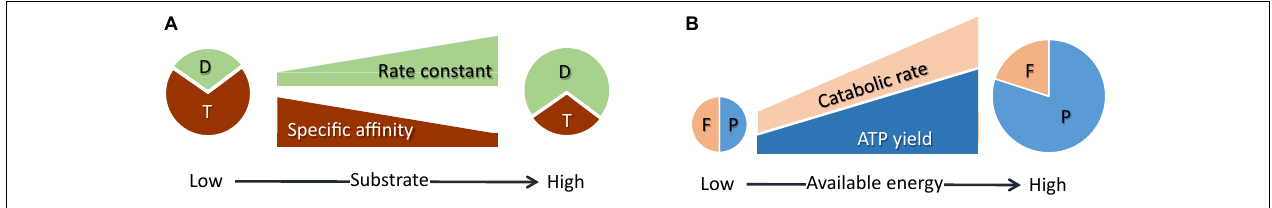
FIGURE 1 | Physiological acclimation model. (A) Microbes partition intracellular resources between the rate-determining step at relatively low substrate concentrations, i.e., substrate uptake (T), and the rate-determining step at relatively high substrate concentrations (D), thereby modulating rate constant and affinity constant (Eqs 16, 17). (B) Microbes partition the energy available in the environment between ATP synthesis (P) and thermodynamic drive (F), trading-off the ATP yield against the rate of catabolism (Eq.